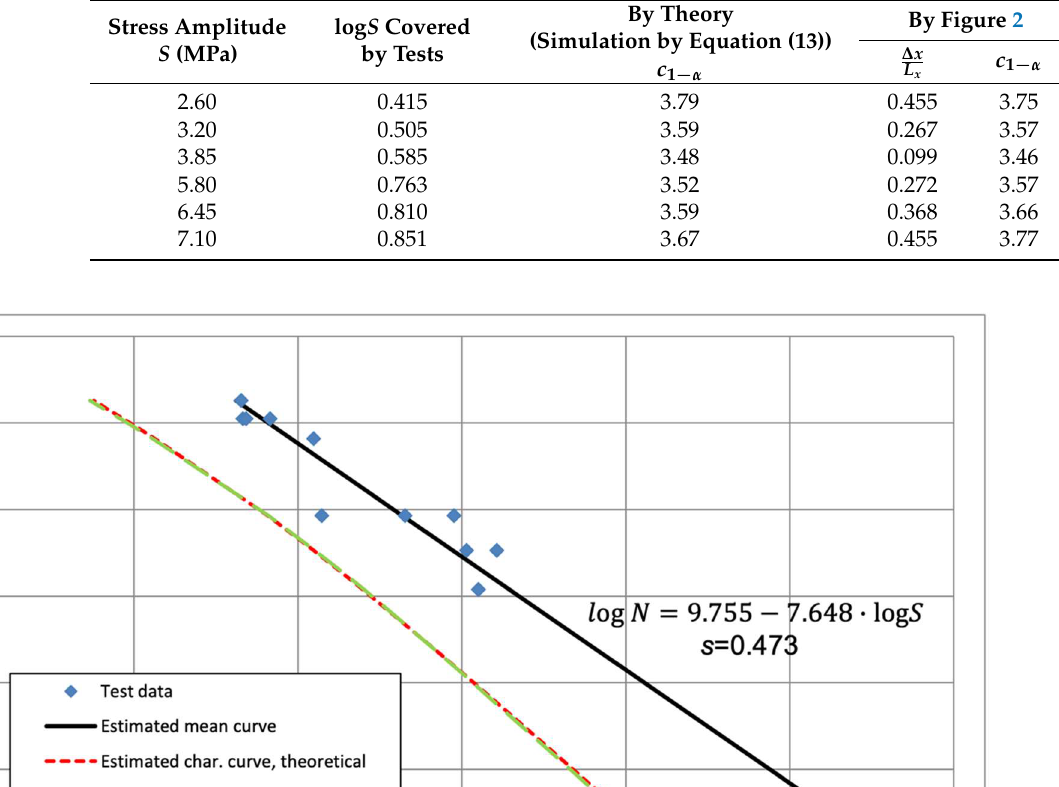
Table 6. Example tests; factor c 1 − α for 1 − α = 0.95.